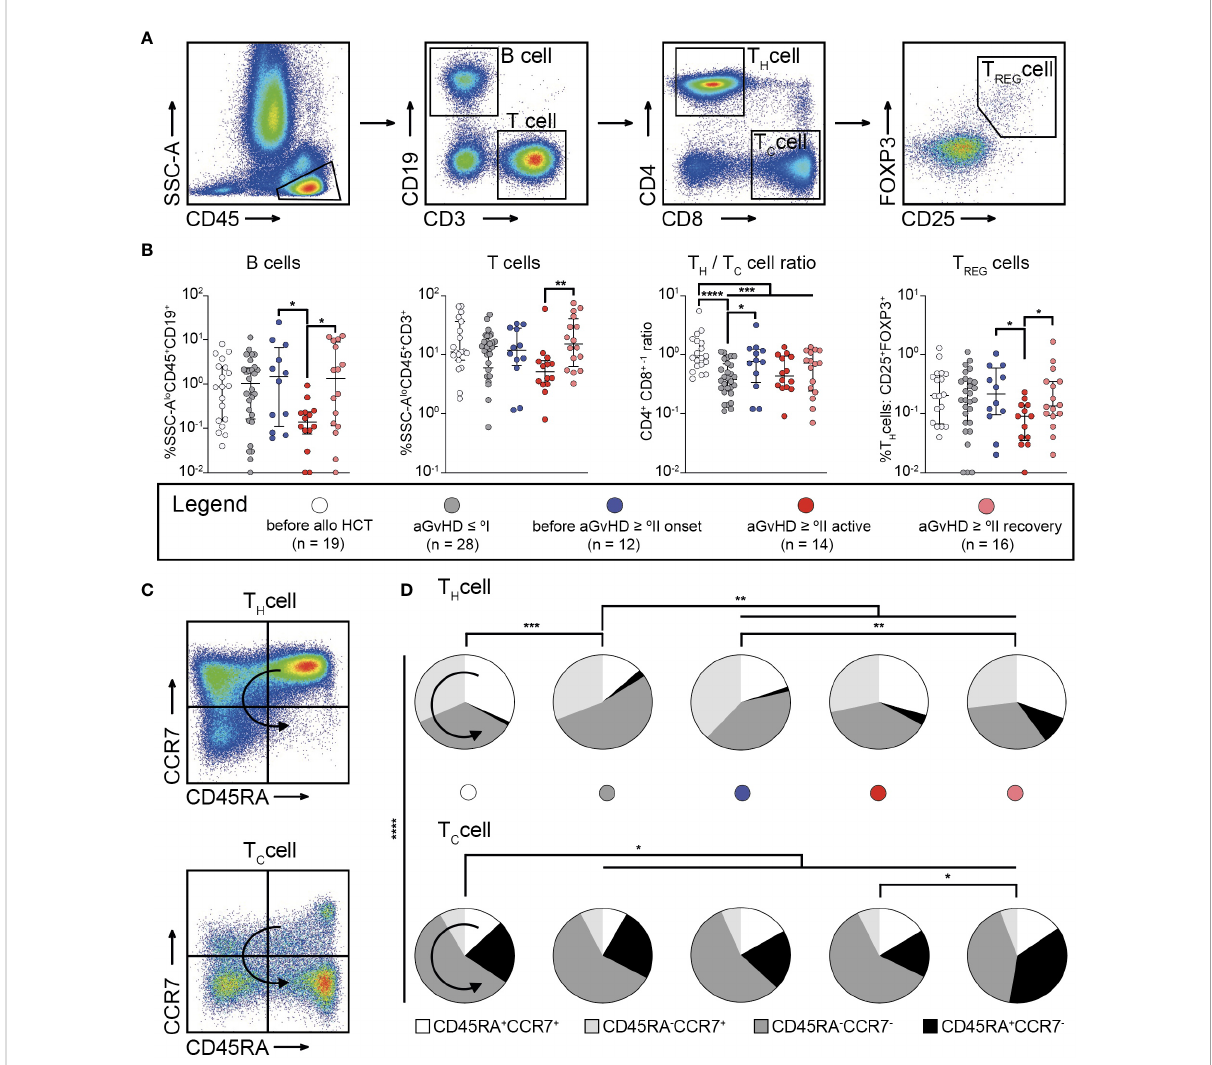
FIGURE 4 Bone marrow graft-versus-host-disease is linked to compartmental in fl ammation and priming of alloreactive T cells. (A) Gating strategy to identify B cells, and T cell subsets within SSC-A low (SSC-A lo )CD45 + cells in bone marrow aspirates. B cells were identi fi ed as CD3 - CD19 + cells, T cells as CD3 + CD19 - cells. T cells could be further subdivided into T helper (T H ) cells (CD4 + CD8 - ), cytotoxic T (T C ) cells (CD4 - CD8 + ), or regulatory T H (T REG ) cells (CD4 + CD25 + FOXP3 + ). (B) Results for the frequency of B cells, T cells, the CD4 + CD8 + -1 ratio, and frequency of T REG cells identi fi ed within bone marrow aspirates from patients before allogeneic stem cell transplantation (alloHCT) (n = 19), and such following alloHCT either with aGvHD ≤ °I (n = 28), before onset of aGvHD ≥ °II (n = 12), with active aGvHD ≥ °II (n = 14), or having recovered from aGvHD ≥ °II (n = 16) are shown. (C) The gating strategy to identify memory or alloreactive subsets within CD4 + and CD8 + T cells according to the expression pattern of CD45RA and CCR7 are depicted. (D) Fractions of memory subsets within CD4 + and CD8 + T cells according to expression of CD45RA and CCR7 in BM aspirates from patients before and after alloHCT. Patients after alloHCT were further strati fi ed according to the occurrence of aGvHD. Graphs show individual values with median and interquartile ranges or pie charts (D) , respectively. The Mann-Whitney test was used for statistical analysis; * P < 0.05, ** P < 0.01, *** P < 0.001, **** P < 0.0001; ↪ direction of